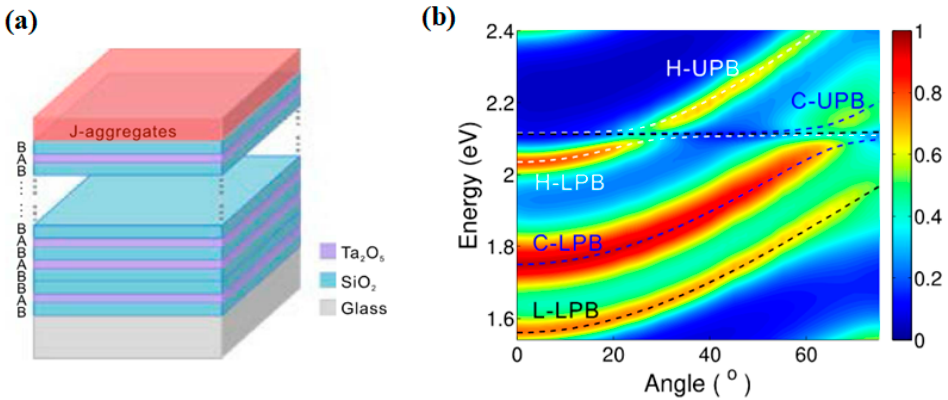
Figure 6. ( a ) Schematic of the photonic quasicrystal covered by the organic semiconductor. ( b ) Two-dimensional dispersion map of the sample covered by the J-aggregates. The dashed lines are the calculated results fitting the polariton bands. Adapted with permission from ref. [118]. Copyright 2016 Optical Society of America.